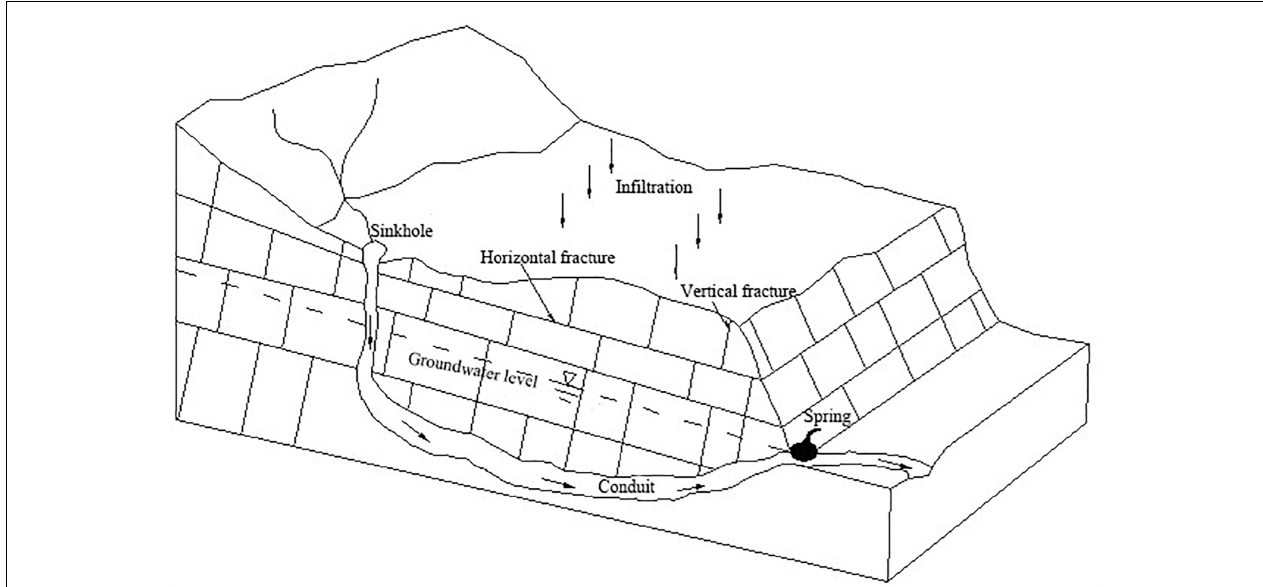
FIGURE 1 | A water cycle in karst aquifer system (adapted from Figure 1.1, Goldscheider and Drew, 2007).